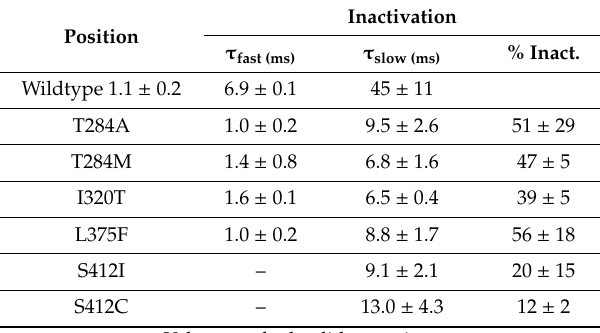
Table 3. Inactivation time constants of the EA1